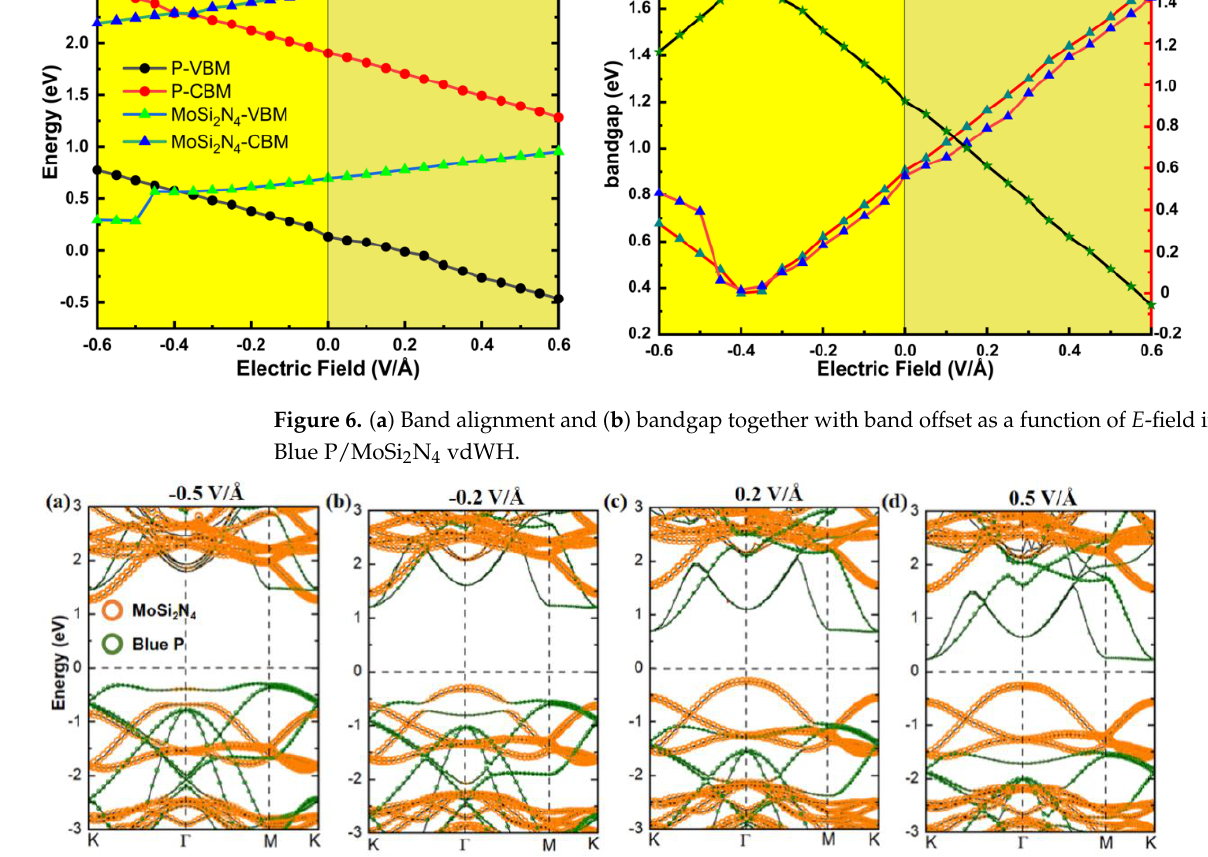
Figure 7. Projected band structures of the Blue P/MoSi 2 N 4 vdWH under the E -fields of ( a ) −0.5, ( b ) −0.2, ( c ) 0.2, and ( d ) 0.5 V/Å. The Fermi levels were set to zero in these panels. ( b ) − 0.2, ( c ) 0.2, and ( d ) 0.5 V/Å. The Fermi levels were set to zero in these